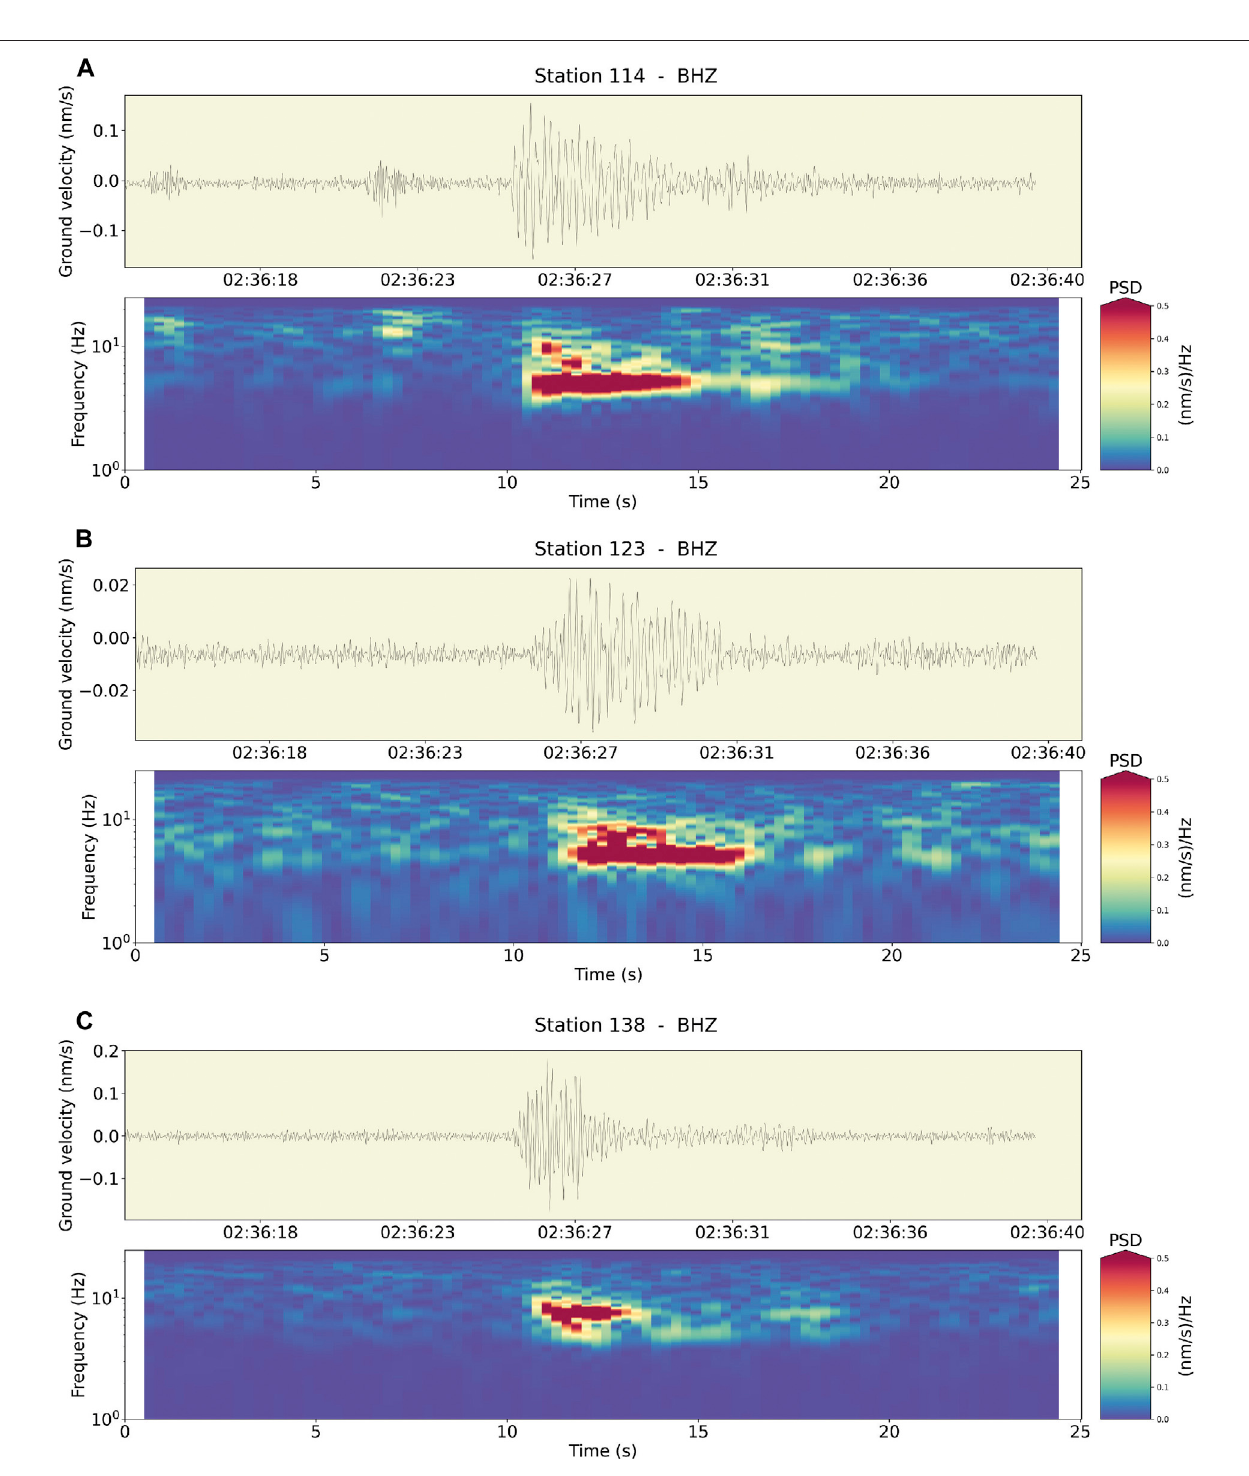
FIGURE 9 | Ground velocity waveforms for the 26 October 2018 02:36 UTC event (top) and corresponding spectrograms (bottom) for stations 114, 123 and 138.